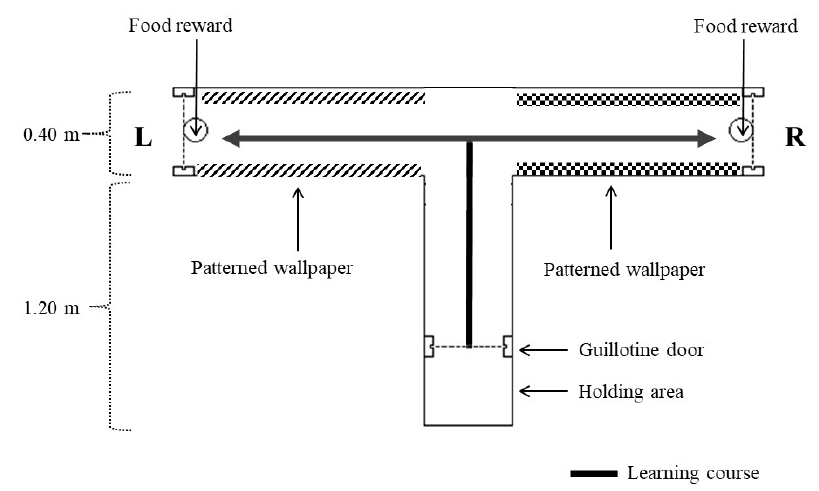
Figure 1. A top-down schematic of the T-maze apparatus showing placement of the food reward (alternating placement at L or R side), patterned wallpaper in the L and R arms, and the learning courses with a guillotine door for keeping birds in the holding area. All maze walls were 0.80 m in height.